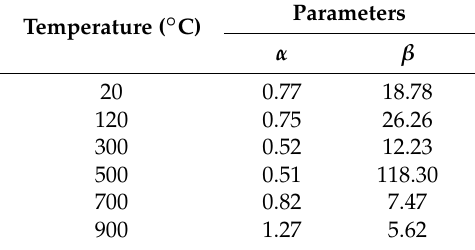
Figure 12. Comparison of the proposed model with experimental results.